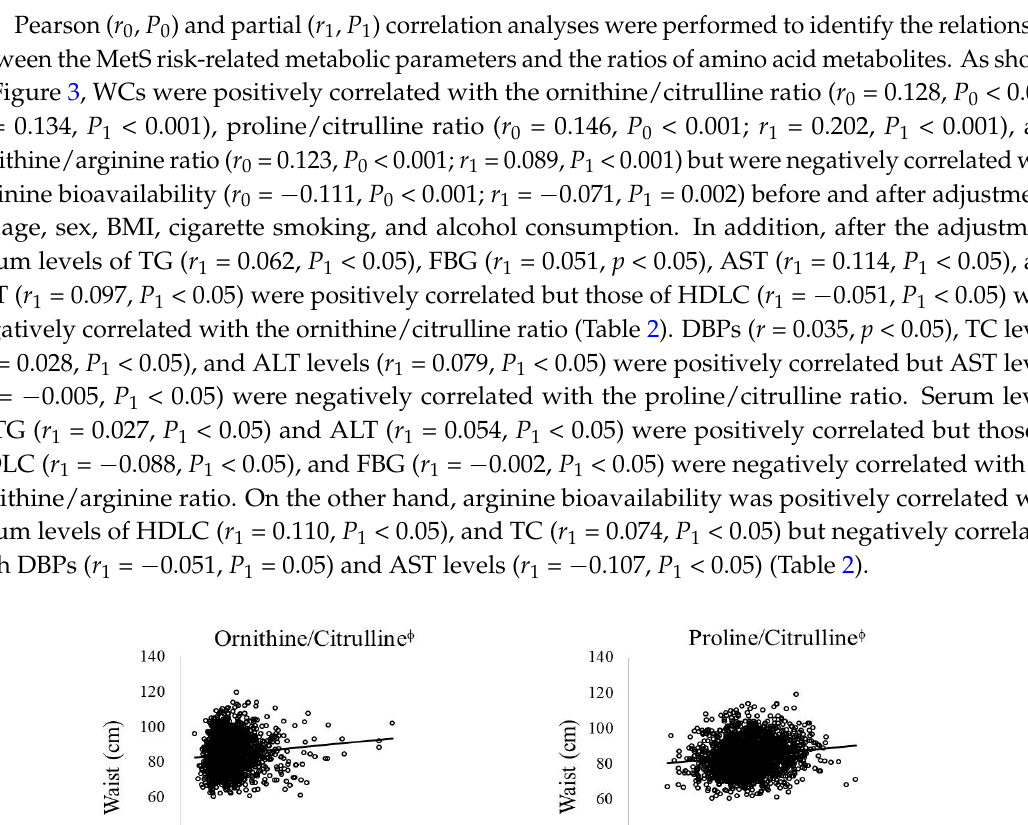
6 of 12 Figure 2. Association between circulating amino acids metabolites and MetS risk status. Data are